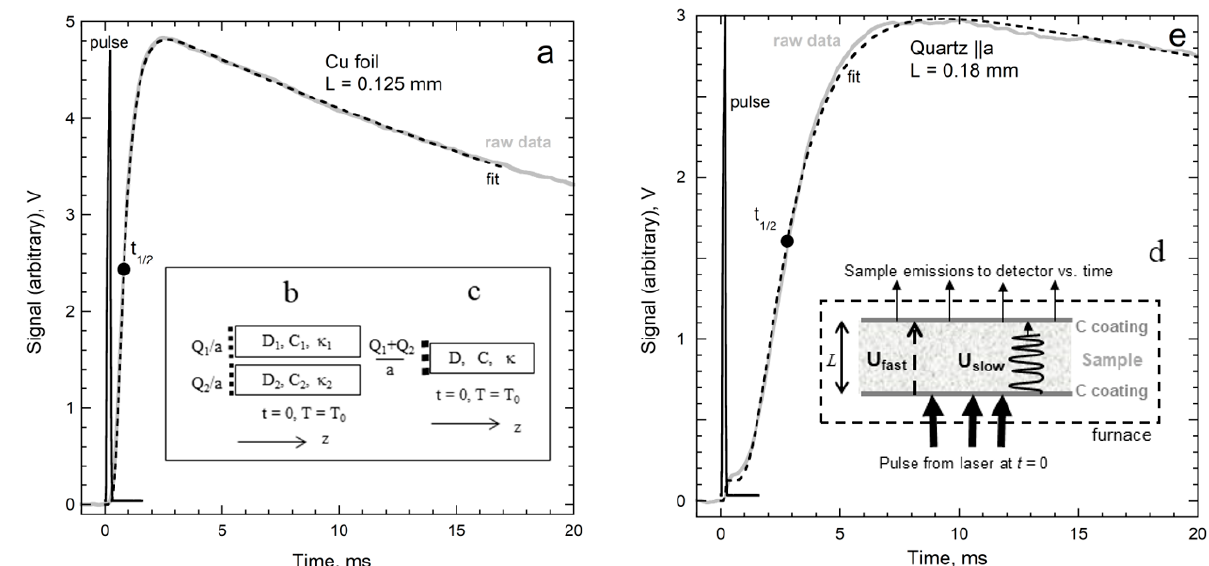
Figure 1. Thermal evolution in LFA (raw data) for thin samples: ( a ) Temperature-time curve of copper foil at 298 K, which initially heats due to the laser pulse (solid curve) and then cools to the surroundings. Raw data (grey) are fit with Cowan’s model. Black dot = position of t ½ . ( b ) Schematic of initial conditions in two parallel bars. Heavy dots represent application of a pulse. ( c ) Schematic of initial conditions for a blended bar, where Q = Q 1 + Q 2 . ( d ) Operation essentials of LFA. Dashed box indicates the furnace enclosing the sample. Speckled rectangle depicts the edge-on the sample of thickness L. Grey shows graphite coatings. Arrows indicate arrival of laser energy and departure of emissions. Dashed arrows show fast ballistic transfer. Squiggle arrows indicate slow diffusive travel of heat across the sample. ( e ) Temperature–time curve of quartz at 298 K, showing a small amount of ballistic transfer, addressed by modeling (Section 3.1.2). Schematics after Figure 5a and Figure 21a,b from Criss and Hofmeister [9], which is open access.